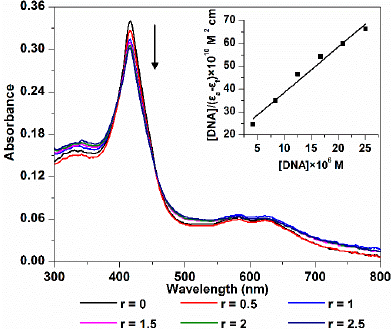
Figure 1. Electronic spectra changes of TCPC (10 µ M) upon addition of ct-DNA ( r = [DNA]/[TCPC] = 0, 0.5, 1, 1.5, 2, 2.5) in Buffer I; the inset is the plot of [DNA]/ | ( ε a − ε f ) | vs. [DNA].